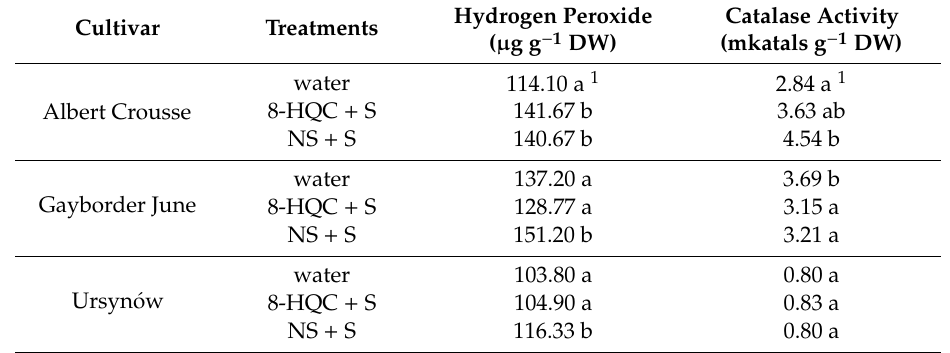
Table 5. The e ff ect of preservatives on the value of oxidative stress parameters in cut peony flowers.